Question: What style of plot is this figure drawn as?
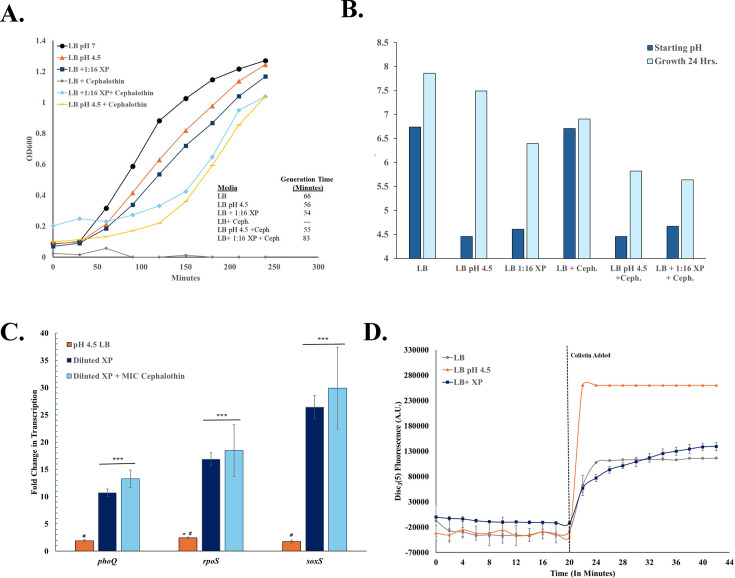
Answer: bar